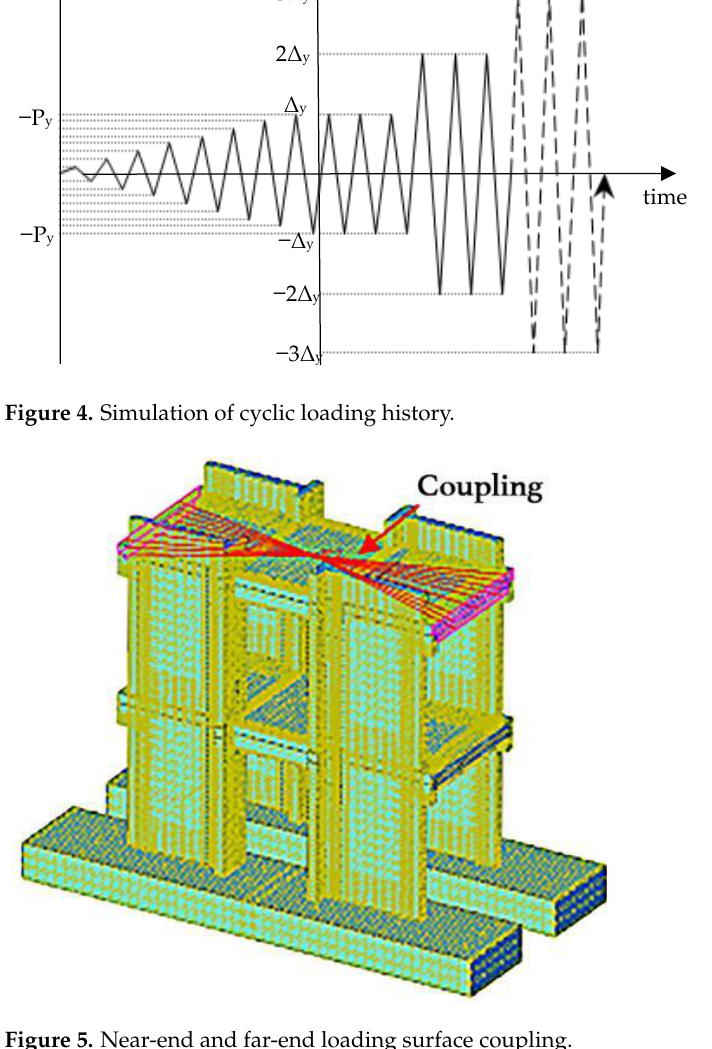
Figure 5. Near-end and far-end loading surface coupling.